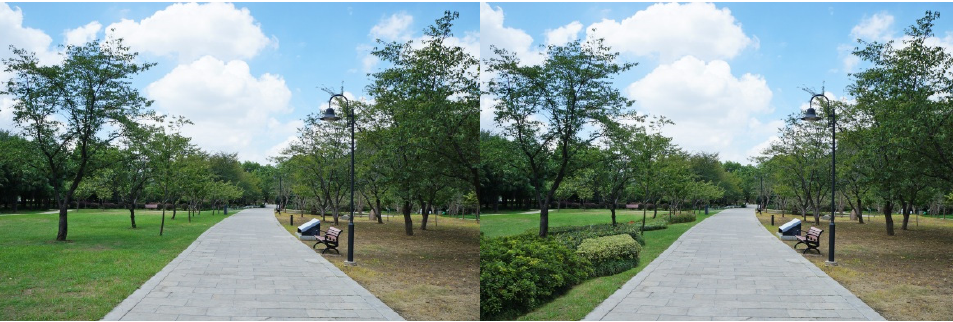
Figure 7. Example: Diverse mix of plants (“barrier” height shrubs were added).